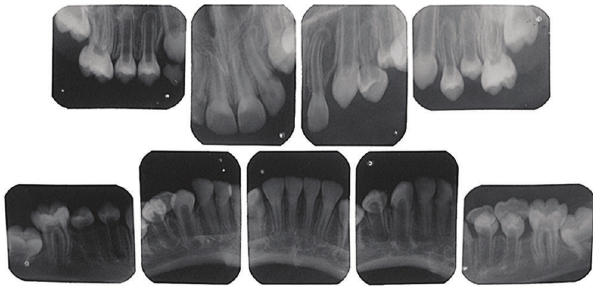
Figure 3: Periapical X-ray showing taurodontic teeth with enlarged pulp chambers and insidious early obliteration of the coronary pulp chambers of the lower incisors.